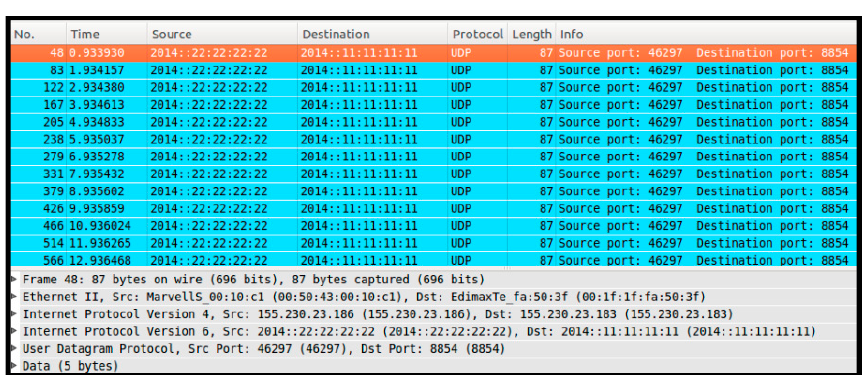
Figure 24. Packet capture (at host 2).